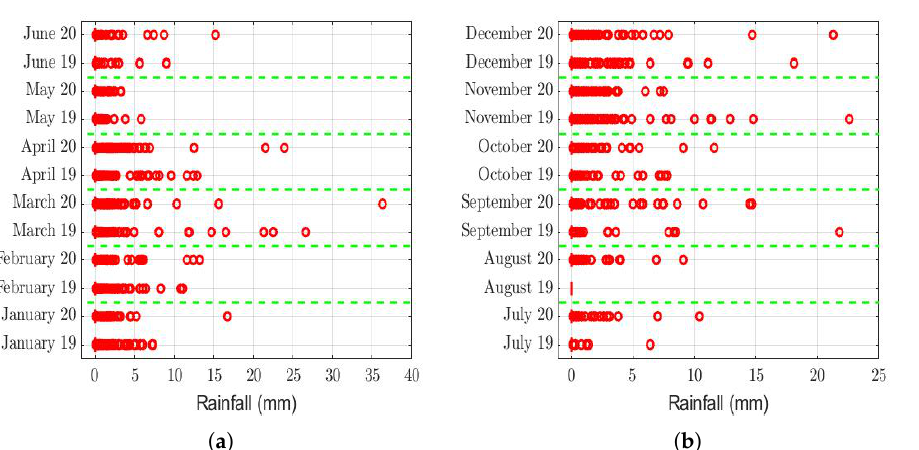
Figure 6. Box plot of the rainfall (mm): 2019 vs. 2020. The red circles represent the outliers. ( a )